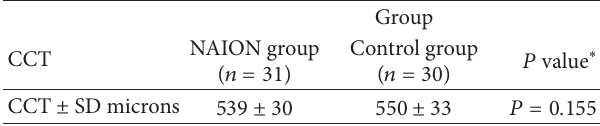
Table 2: Mean CCT in NAION and control